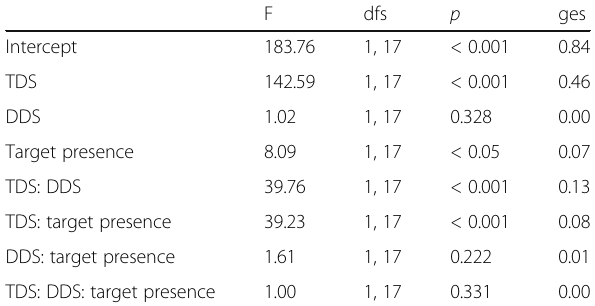
Table 1 ANOVA (type III) on slopes over set size